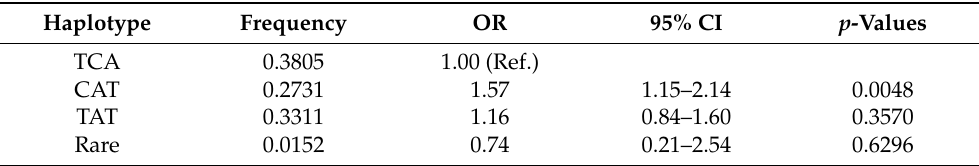
Table 5. Results of regression analysis of association between haplotypes of SLC1A2 gene (SNPs rs1042113, rs10768121, and rs12361171) and tardive dyskinesia. Haplotype Frequency OR 95% CI p -Values TCA 0.3805 1.00 (Ref.) CAT 0.2731